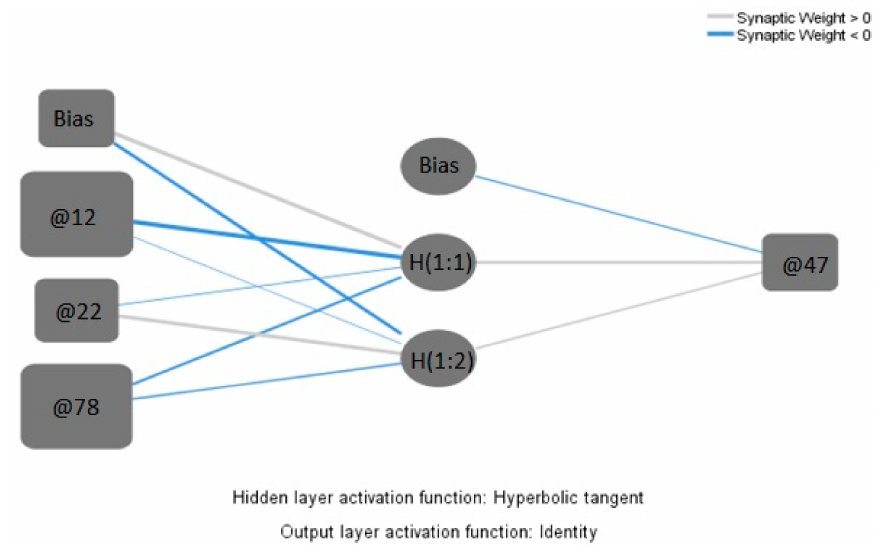
Figure 10. The artificial neural network–perceptron graphic